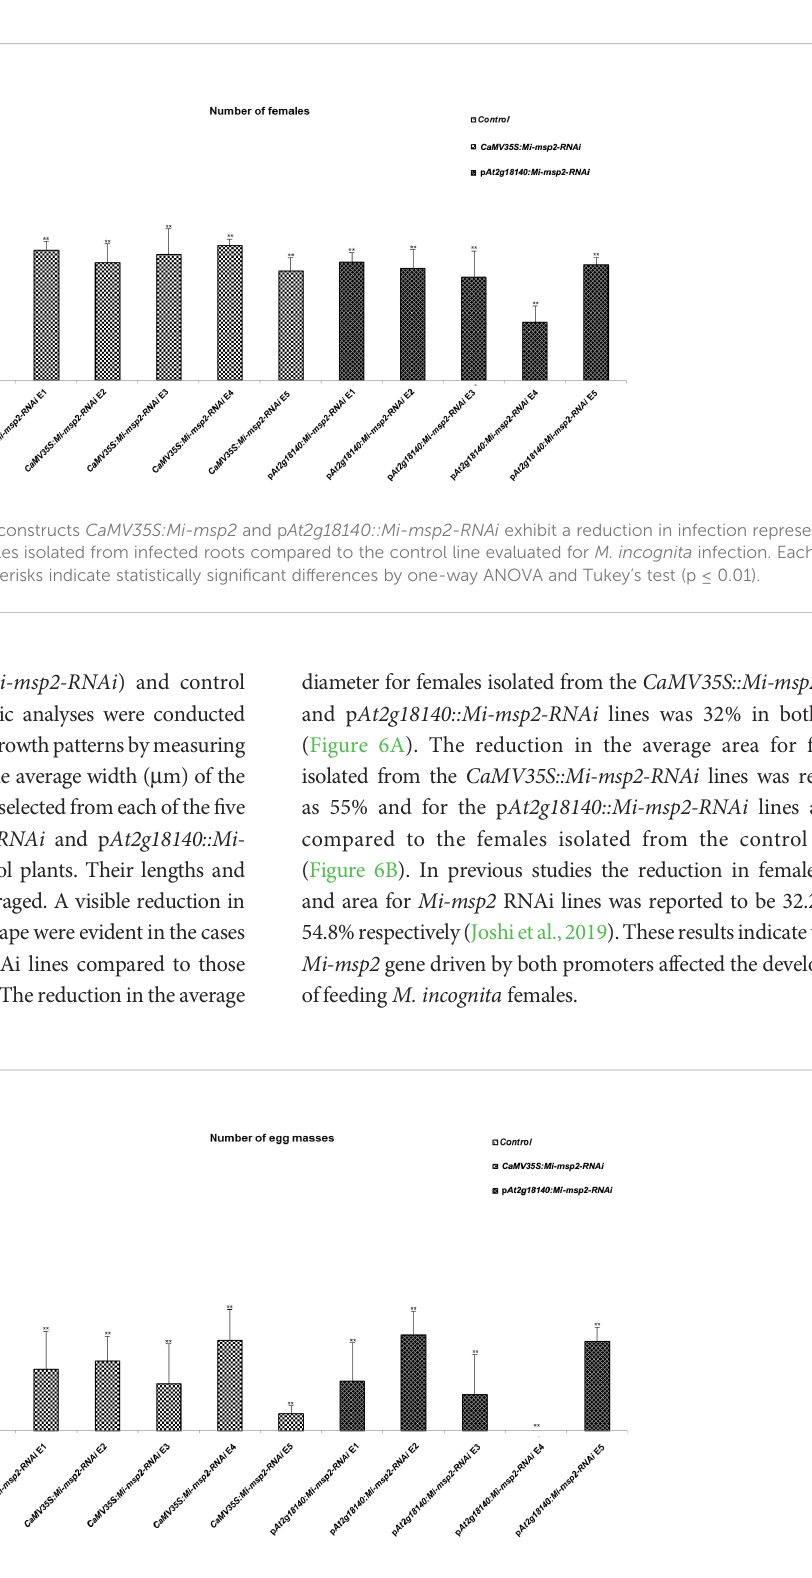
FIGURE 4 Five independent RNAi lines each for constructs CaMV35S:Mi-msp2 and p At2g18140::Mi-msp2-RNAi showing a reduction in infection represented by a reduction in the number of egg masses produced by the females in infected roots compared to the control line evaluated for M. incognita infection. Each bar represents the mean ± SE. Double asterisks indicate statistically signi fi cant differences by one-way ANOVA and Tukey ’ s test (p ≤